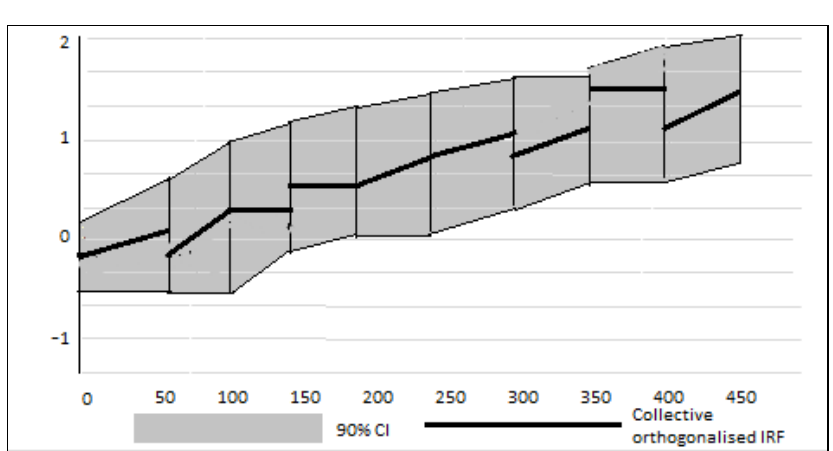
Figure 2. Owned Media Marketing. Source: Collective orthogonalized instinctive response of outbound and user-owned media on new sales.